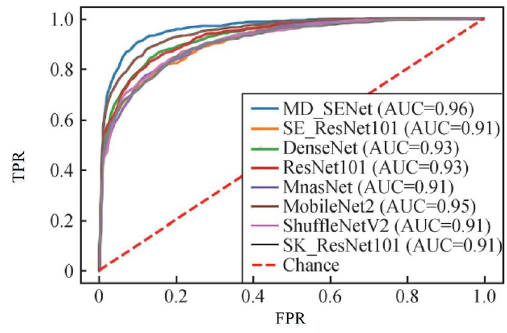
Fig. 12 Comparison of ROC curves with different